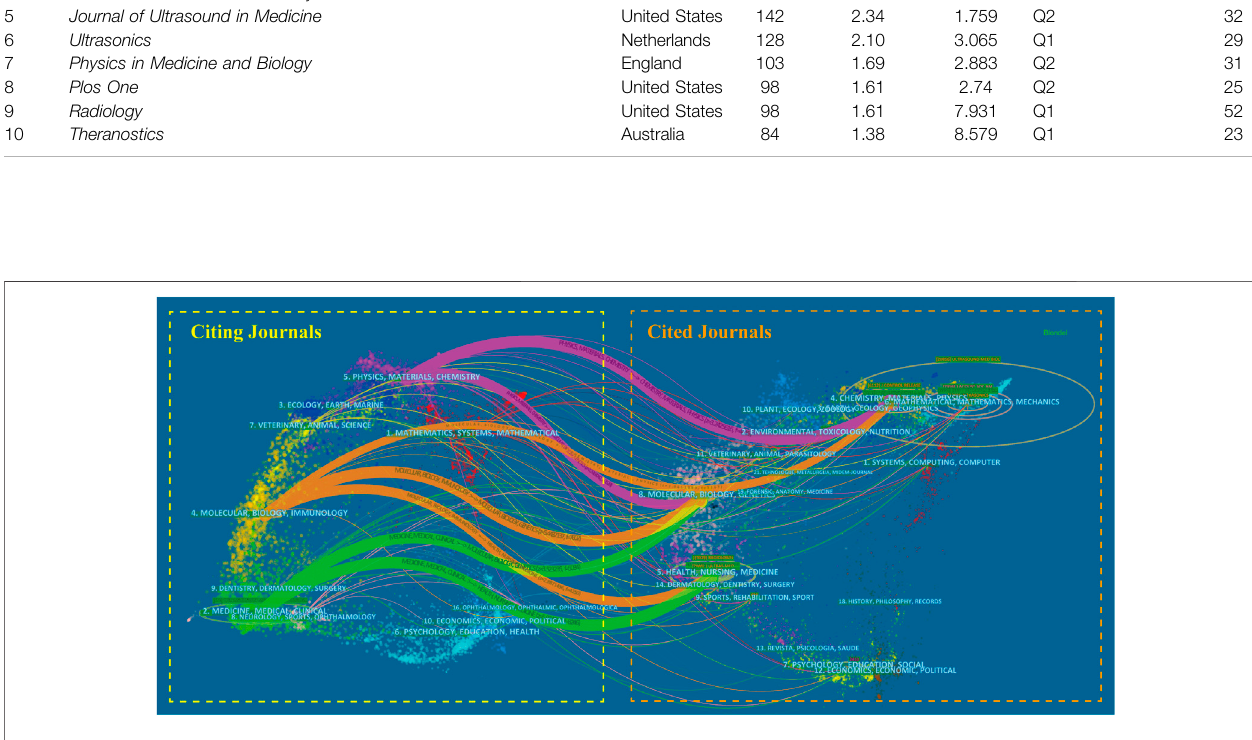
FIGURE 7 | Dual-map overlay of the journals on ultrasound microbubble research generated by CiteSpace. The labels represent different research subjects covered by the journals. The citing journals are on the left side, while the other side of the map represents the cited journals. Different colored lines correspond to the different paths of references, beginning with the citing map and ending at the cited map. The path widths are scaled proportionally to the frequency of z -score-scale citation.